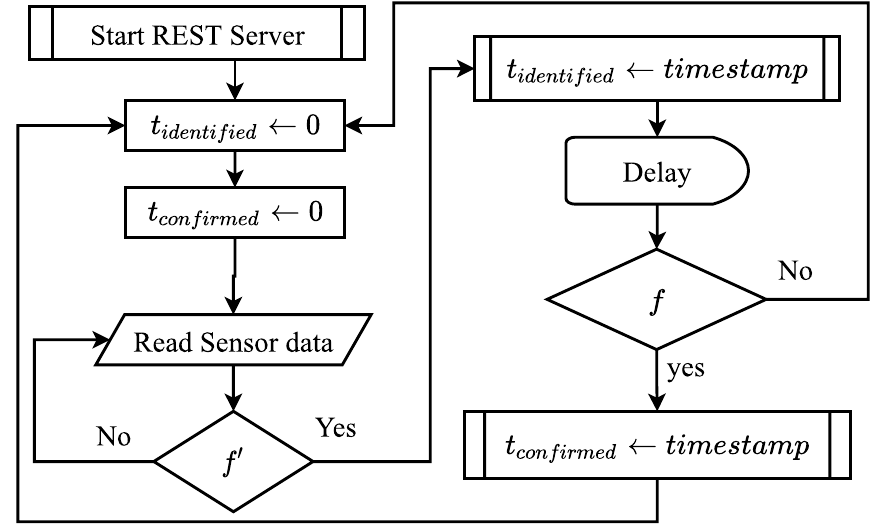
Fig. 10 Instrumenting and exposing relevant metrics at edge level